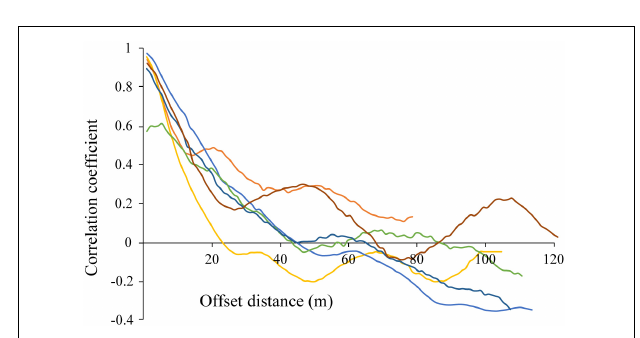
FIGURE 8 | Correlogram for estimated chl-a derived from optical measurements made along each of the out and back AUV transects CE1, CE2, and CE3 (6 total; shown in individual colors). Repeat mission of CE1 at night not